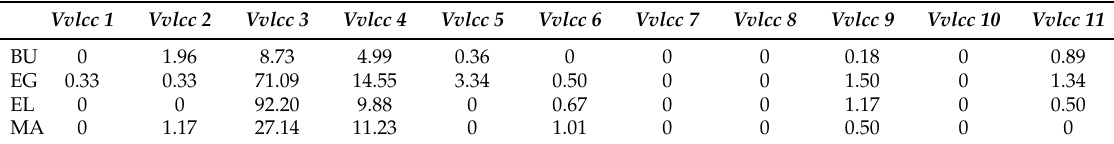
Table 1. Differential expression levels of the laccase genes at different developmental stages (from button stage to maturation stage). BU (Button stage): the stage after inoculating spawn 10 days on rice straw compost; EG (egg stage): the stage after inoculating spawn 13 days; EL (elongation stage): the stage after inoculating spawn 13.5 days; MA (maturation stage): the stage after inoculating spawn 14 days.